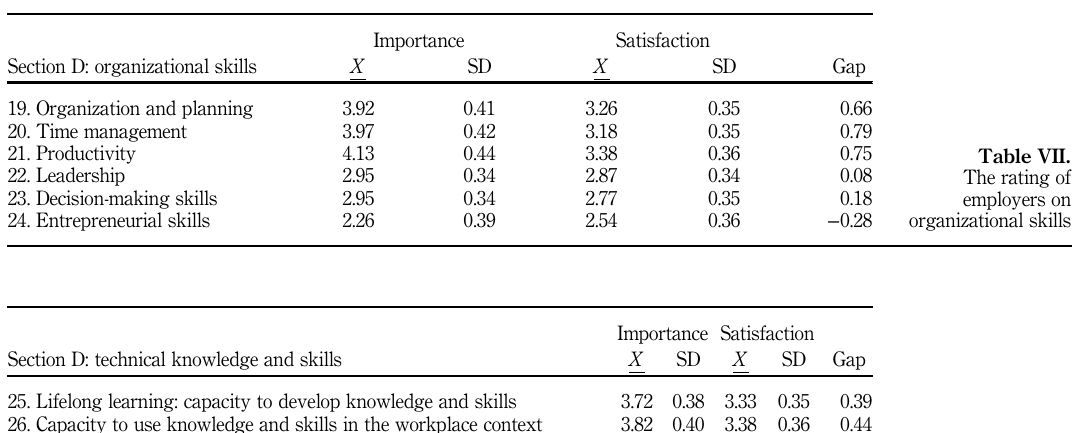
Table VIII. The rating